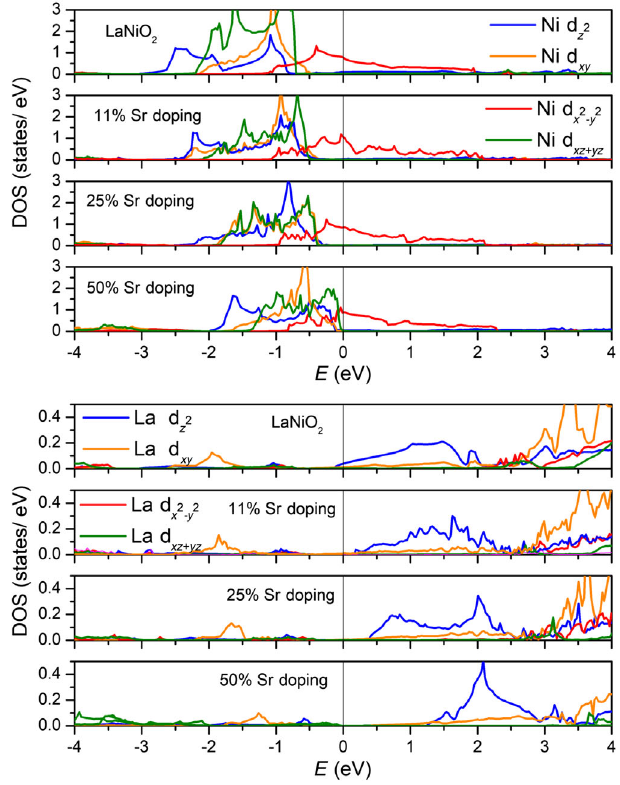
FIG. 4. Comparison of the orbital-resolved Ni d (top panels) and La d (bottom panels) density of states for increasing Sr doping in LaNiO 2